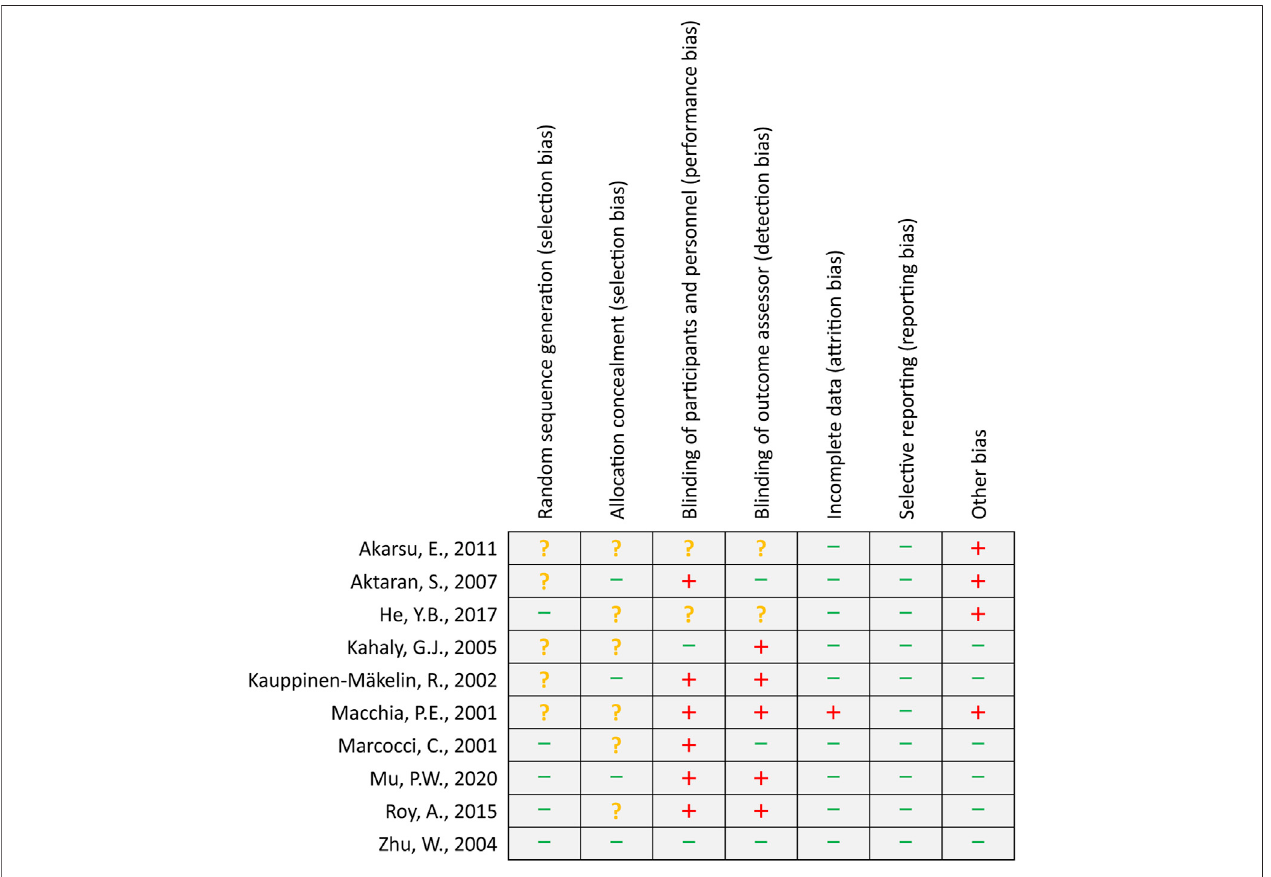
FIGURE 2 | Risk of bias summary. The green minus sign, yellow question mark, and red plus sign represent low, unclear, and high risk of bias, respectively.